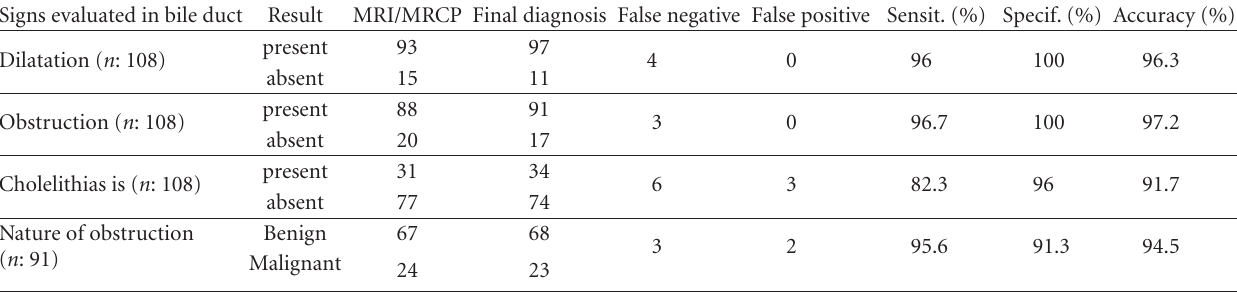
Table 2: Signs evaluated with MRI/MRCP and comparison with final diagnoses. Signs evaluated in bile duct